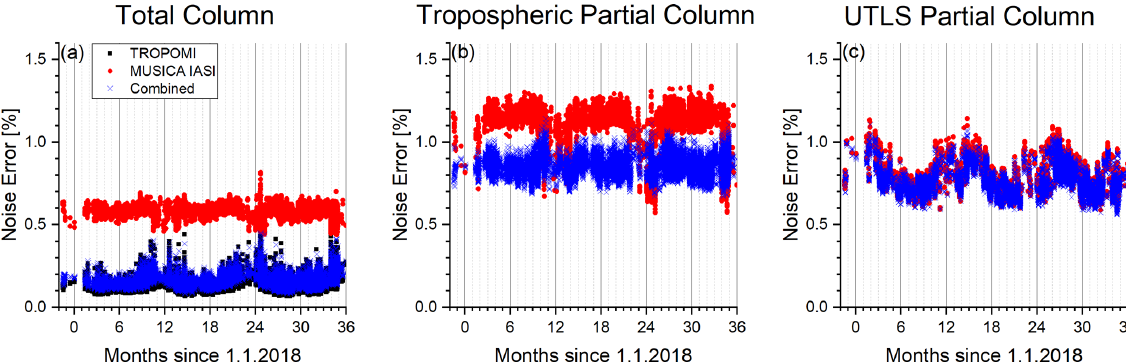
Figure 6. Time series of estimated relative noise error for the retrieved products (example for central Europe). Colours are as in Fig. 5. (a) Total column, (b) tropospheric partial column, and (c) UTLS partial